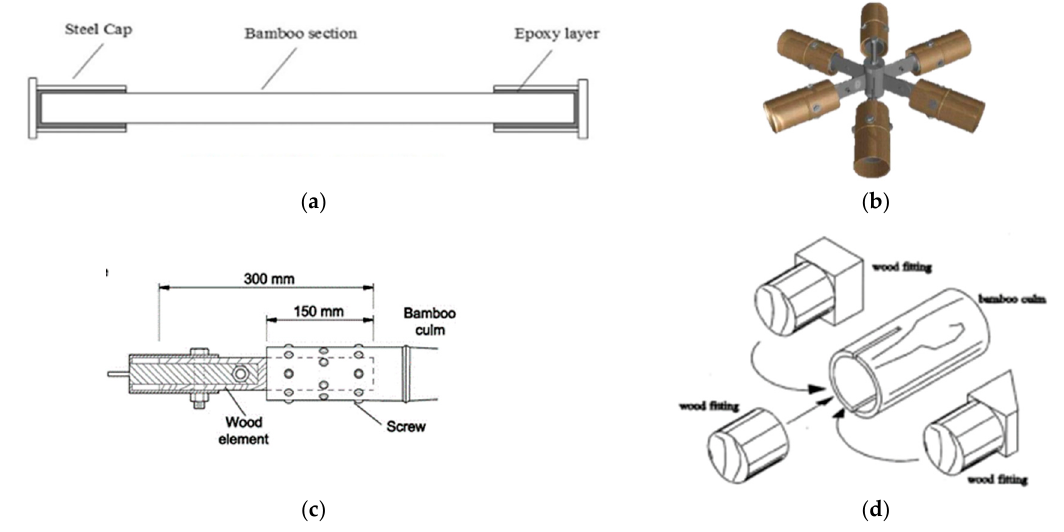
Figure 1. ( a ) Joint with steel pipe capped at bamboo ends (Adhikari et al., 2015) [11]. ( b ) Joint with steel pipe inserted at bamboo ends (designed by Shoei Yoh, cited in Disén and Clouston 2013) [13]. ( c ) Joint with wood fitting and screws (Fabiani 2014) [14]. ( d ) Joint with round wood block inserted in bamboo culm (Arce 1993) [15].